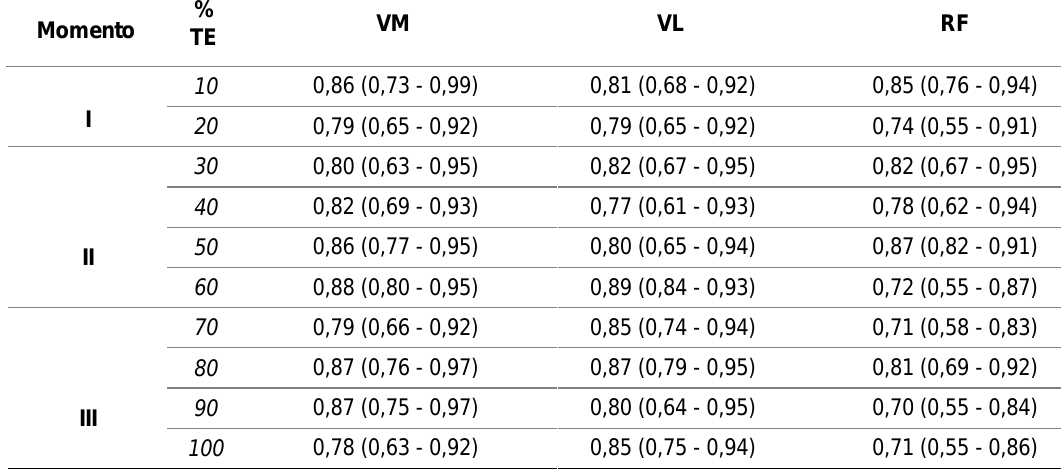
Tabela 2. Valores de CCI e seus respectivos intervalos de confiança (95%) para a Fmed a cada 10%